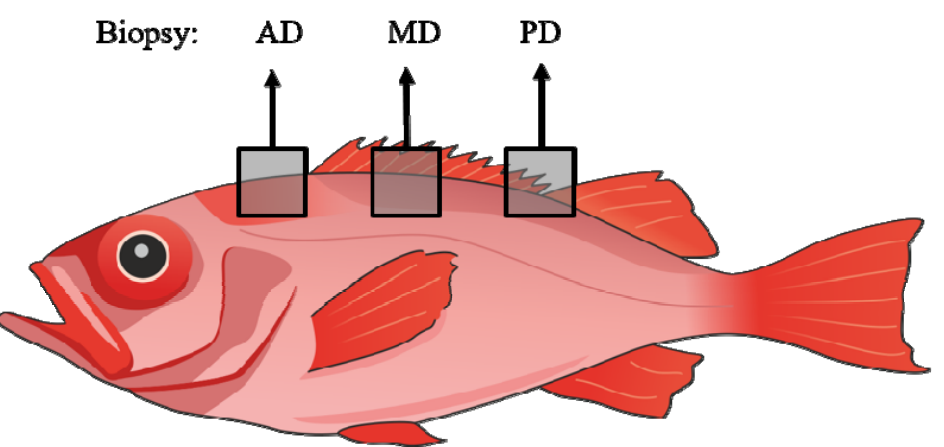
Figure 1. Schematic view of biopsies of muscle tissue from the commercial beaked redfish Sebastes mentella .